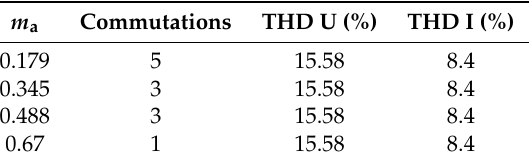
Table 3. Number of switch commutations per period of the output voltage and the THD (of voltages and currents) for the coarsely quantized pulse amplitude modulation (CQ-PAM) presented in Figure 9.